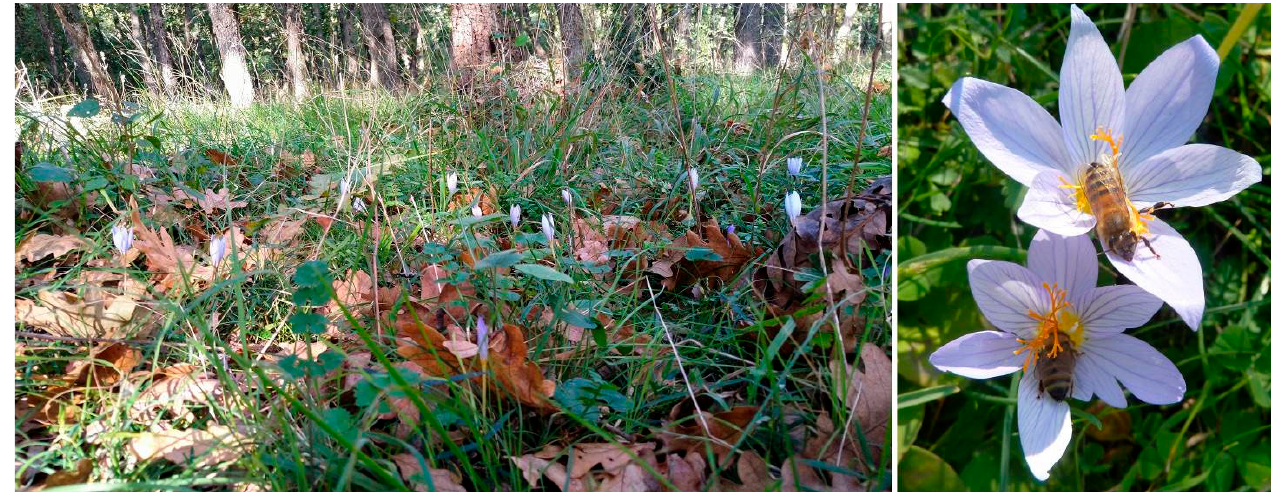
Figure 5. Habitat and pollination of C. speciosus.